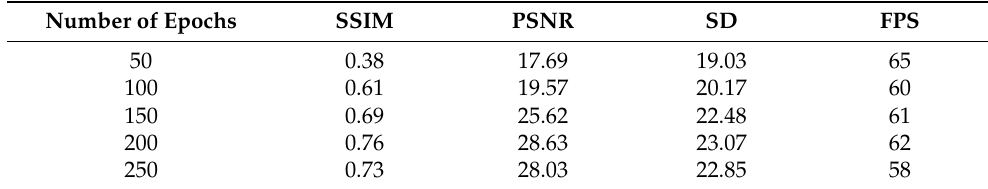
Table 9. Impact of varying epoch numbers on experimental results.